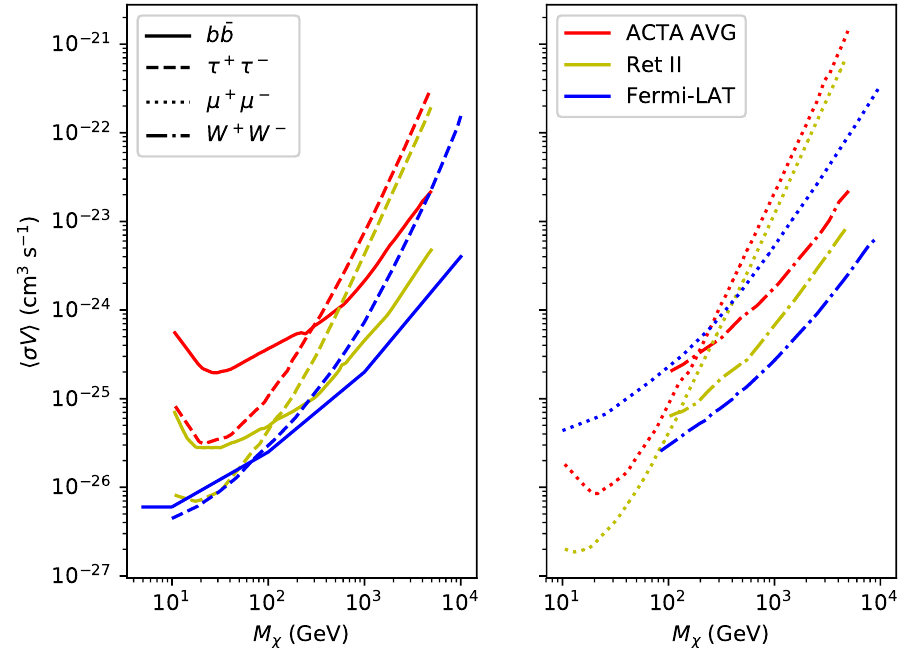
Figure 1. Cross-section upper limits from existing searches, presented at a confidence level of 95%. Four annihilation channels are covered and we display results from Fermi-LAT [6], the AVG diffusion scenario from [29], and Reticulum II results from [30]. The left panel shows the b -quark and τ -lepton channels. The right panel shows W -boson and muon channels.